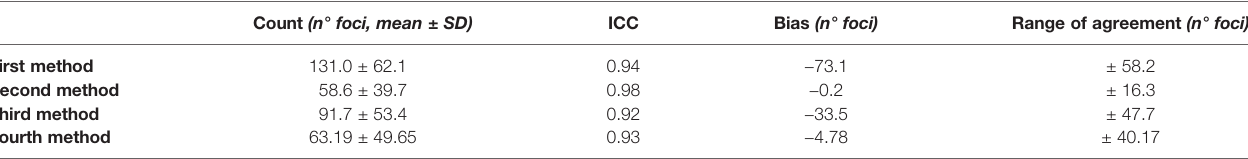
TABLE 2 | Statistical analysis results of each